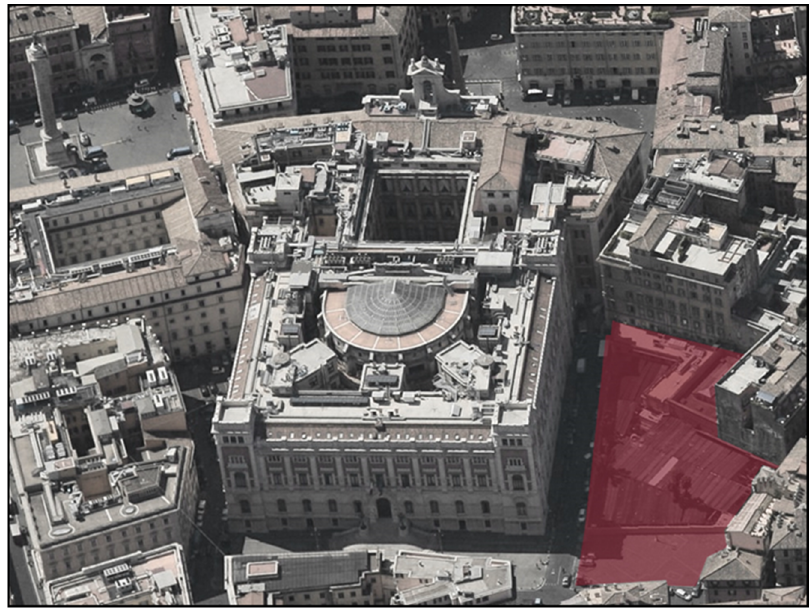
Figure 1. Aerial view of Montecitorio with the project area marked in red. Table 1. Selected projects in the architectural competition.